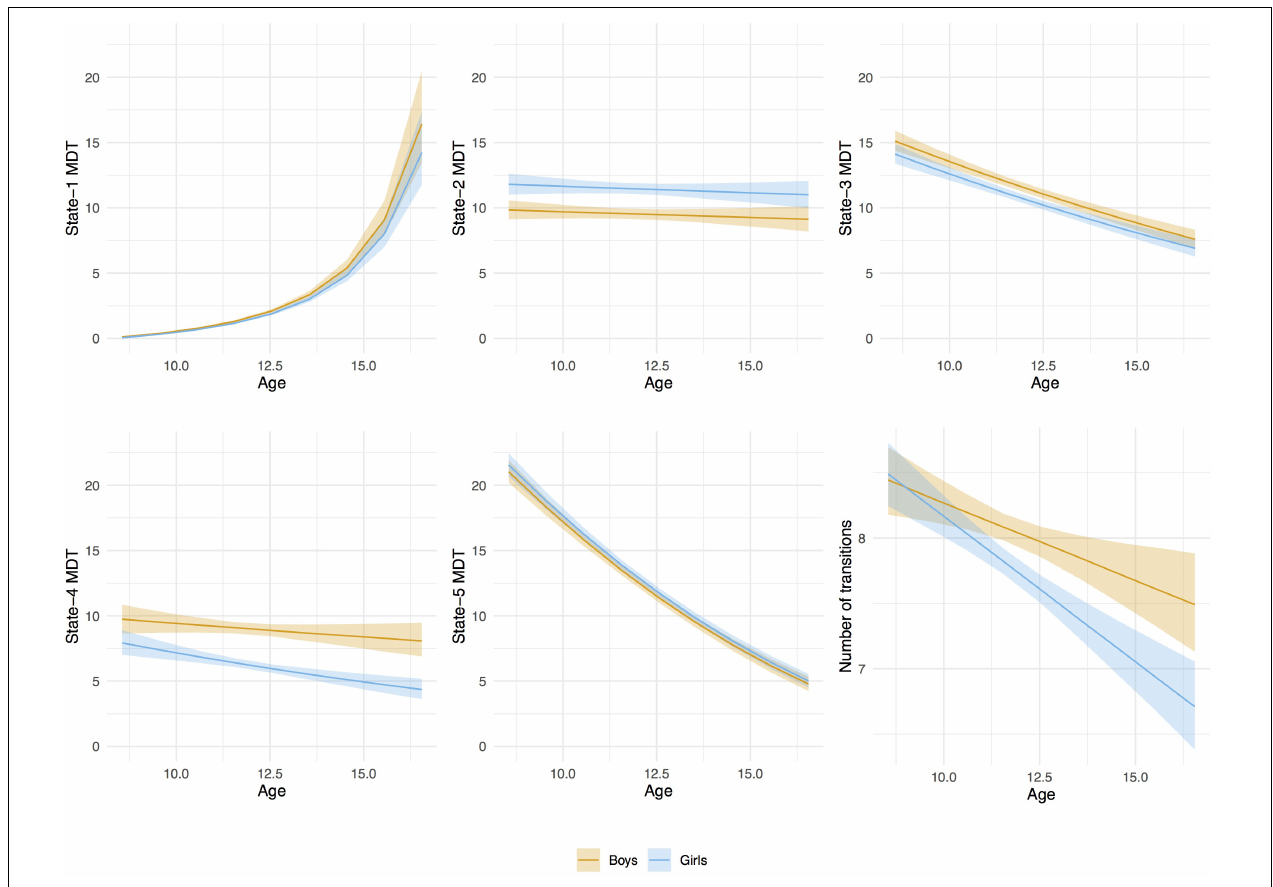
FIGURE 7 | Age-associations with mean dwell time (MDT, number of time windows) in each state and number of transitions between states by sex. Linear mixed-effects models (random effect: subject). The MDT values were transformed back to the original scale for the graphical representation of the associations. A bootstrap technique was applied using 2,000 resamples with replacement to estimate the variation of the values in the